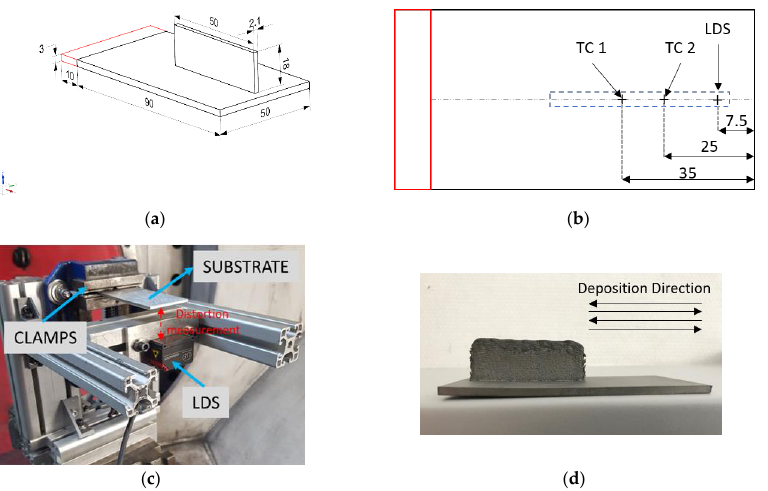
Figure 2. ( a ) Substrate and wall build dimensions (in mm); ( b ) Measurement locations at the substrate; ( c ) Experimental set-up of the in situ measurement; ( d ) Post-process wall build along with the depiction of the deposition strategy.